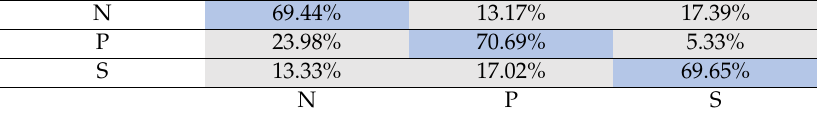
Table 6. Confusion matrix of CBAMNet. N: negative; P: positive; S: surprise.